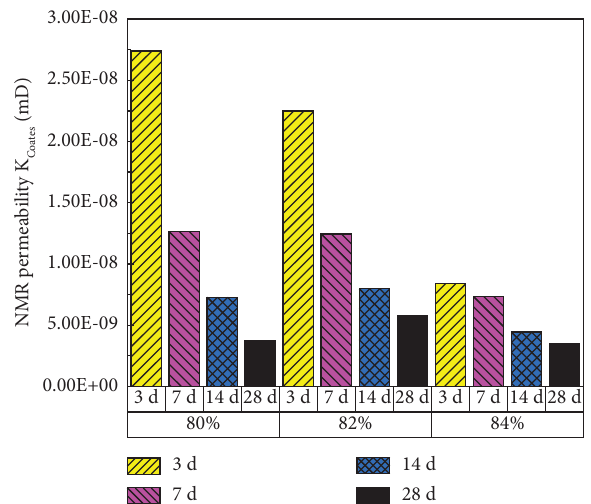
Figure 11: Internal nuclear magnetic permeability of CGGCFB at diferent ages and mass concentrations ( K